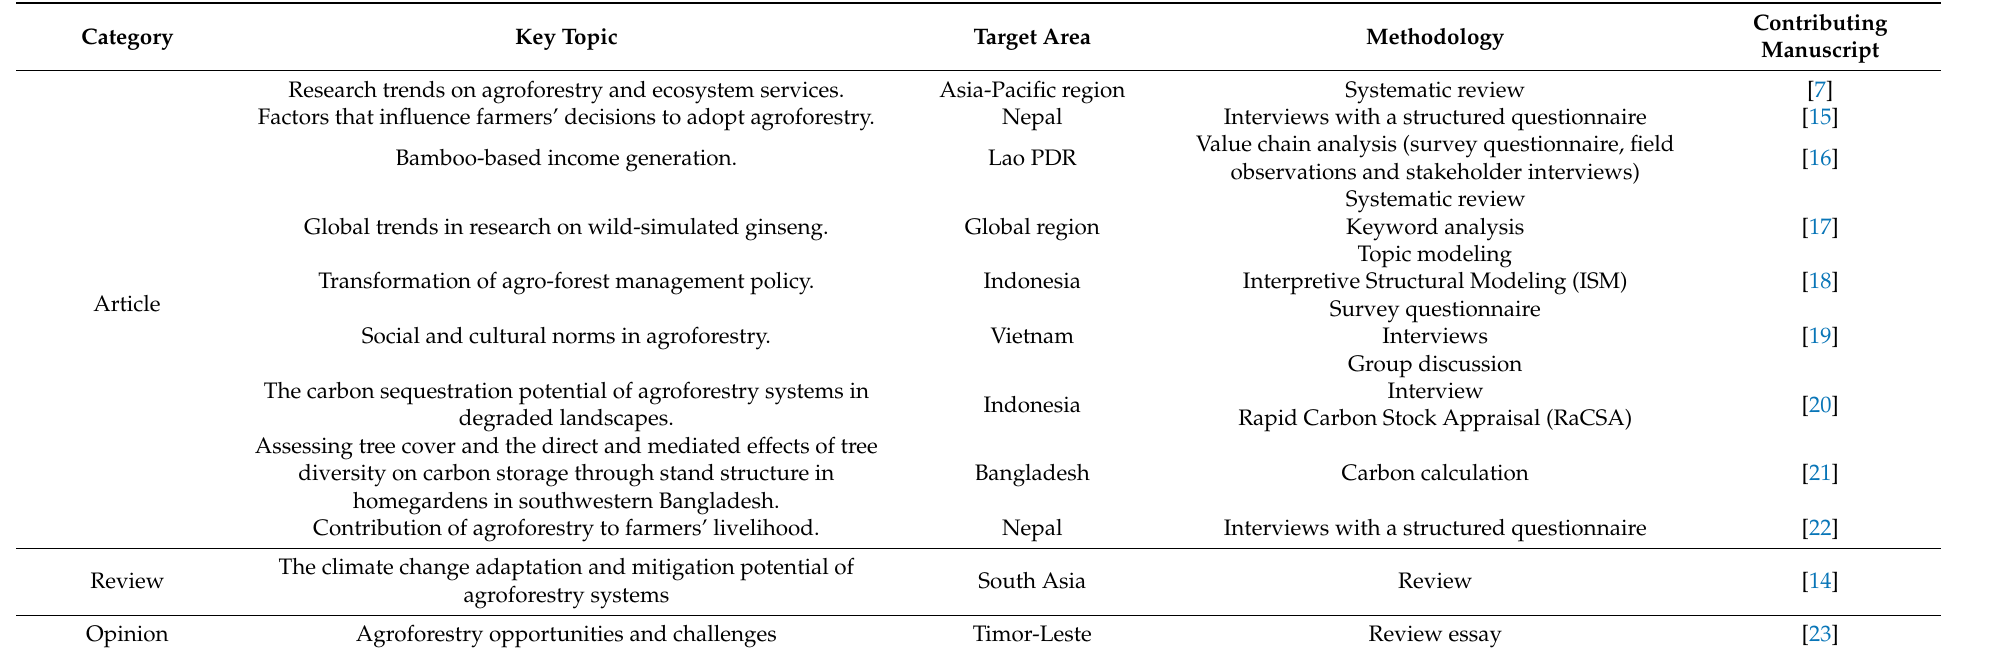
Table 1. Highlights of research papers presented in the Special